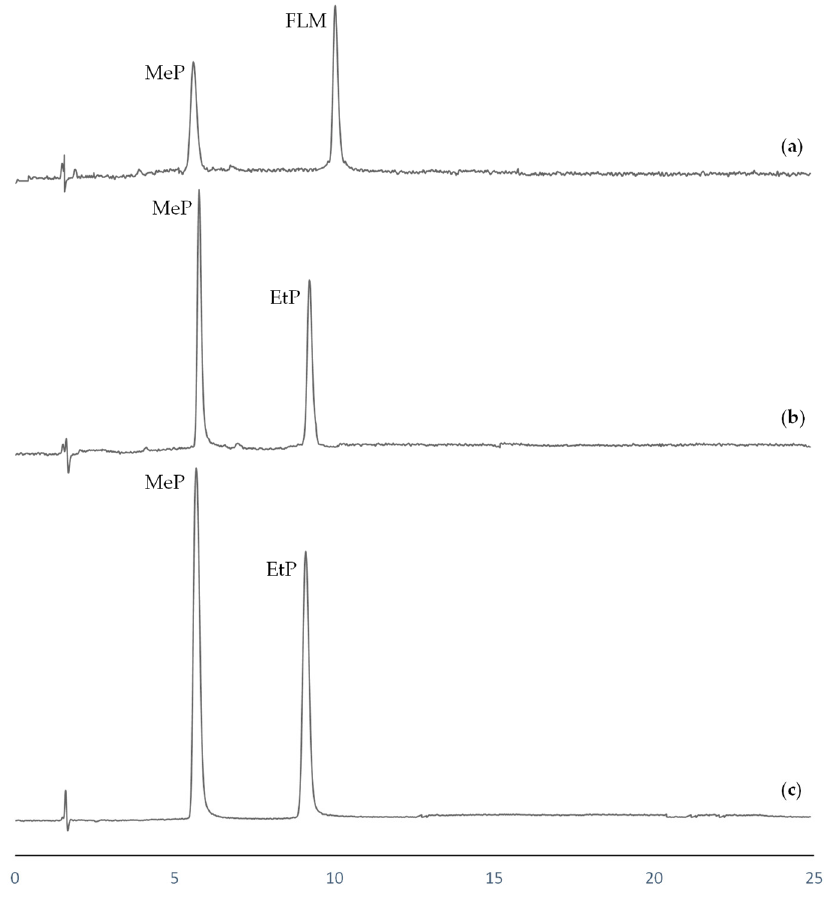
Figure 3. HPLC chromatograms after EME procedure corresponding to ( a ) lake water; ( b ) river water; ( c ) swimming pool water.